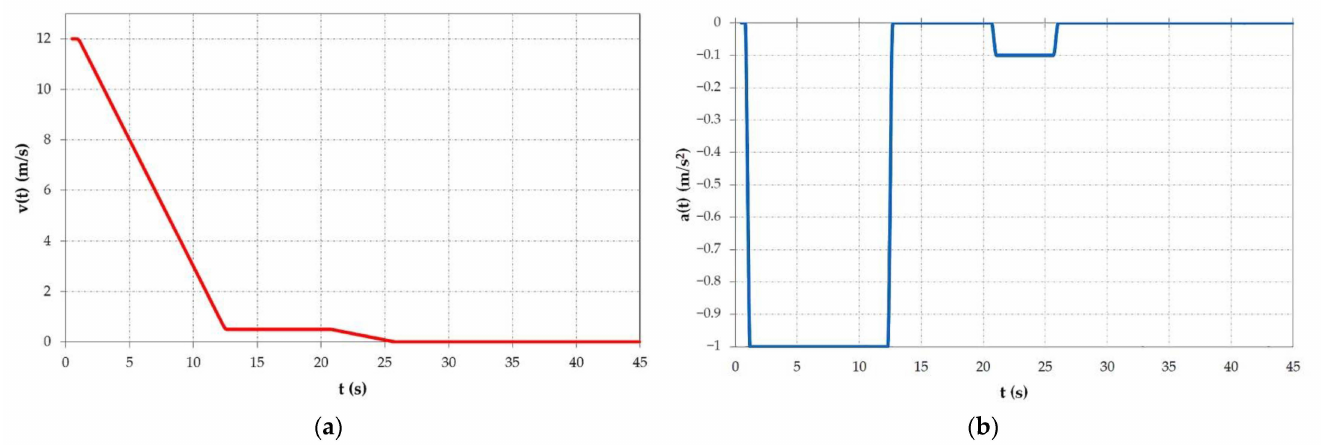
Figure 5. Diagrams obtained in COMSOL for ( a ) velocity and ( b )